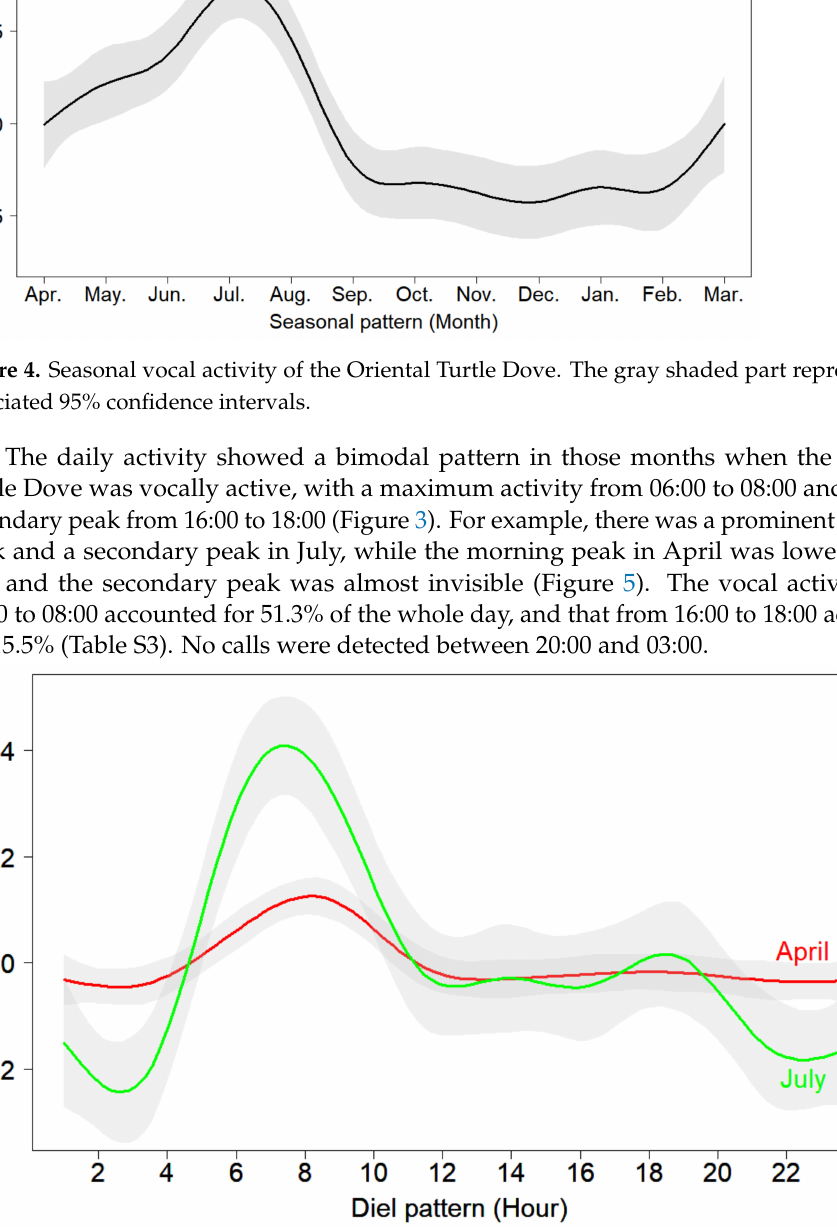
Figure 5. Daily vocal activity of the Oriental Turtle Dove in April and July. The gray shaded part represents the associated 95% confidence